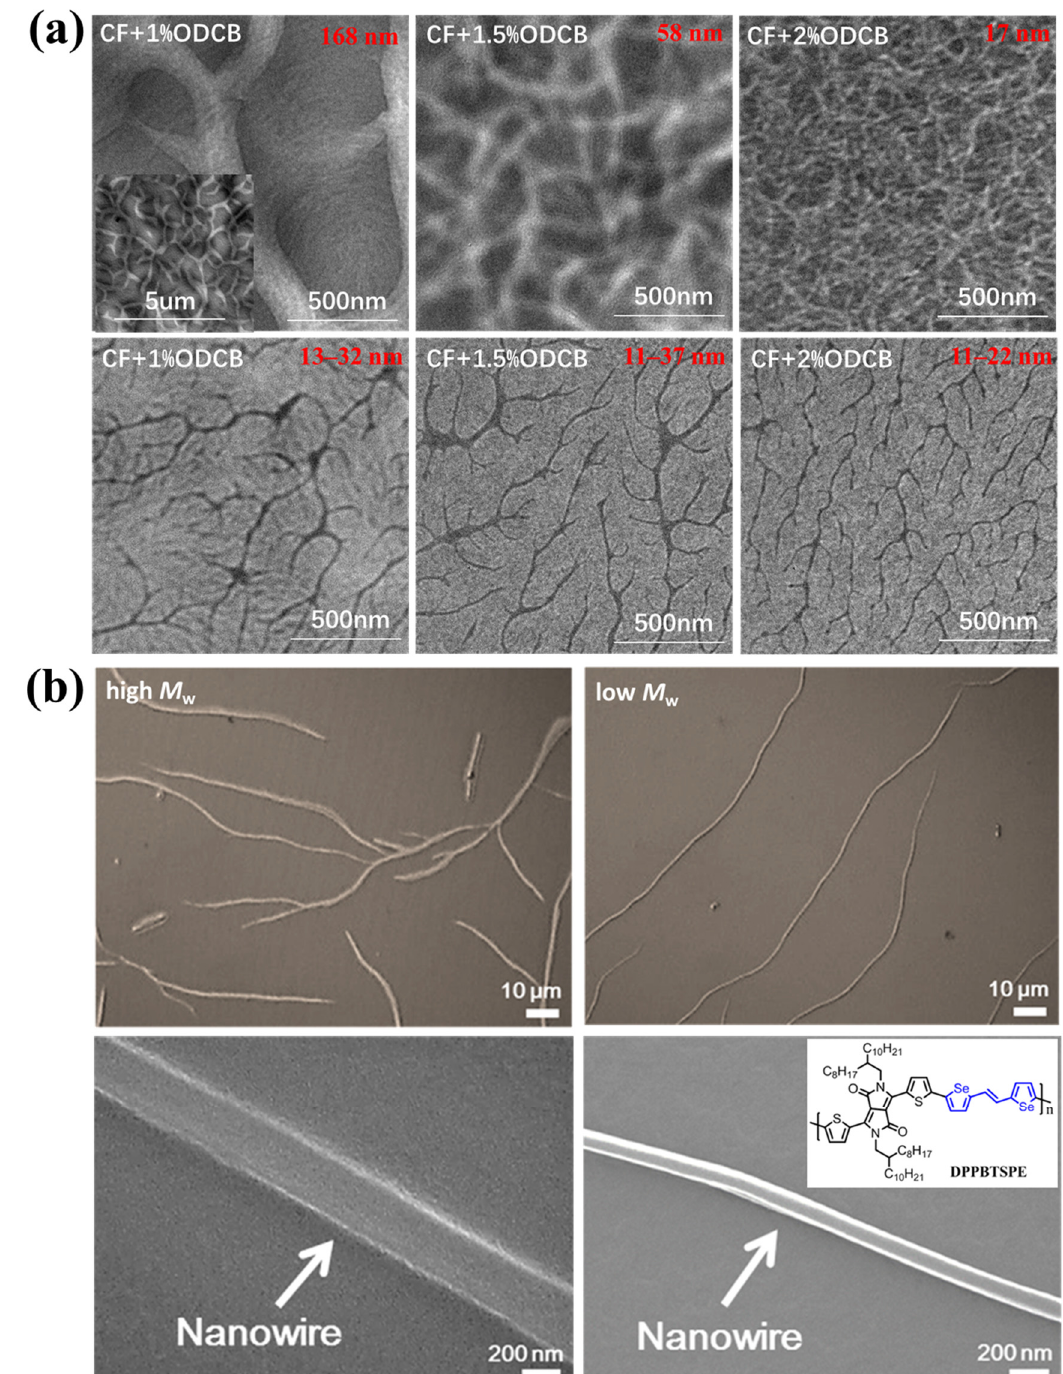
Figure 6. ( a ) TEM images of PDQT:PC 71 BM blend films ( top ) and pure PDQT films ( bottom ) pro- cessed with different amounts of solvent additive ODCB, which were adapted from reference [113] with permission from Copyright 2017 Wiley Periodicals LLC. ( b ) TEM images of high- and low-MW DPPBTSPE nanowires, which were adapted from reference [80] with permission from Copyright 2015 American Chemical Society.